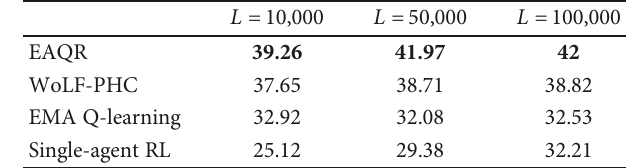
Table 6: Minimal cumulative reward for the DSN problem (evaluation episodes =5000).